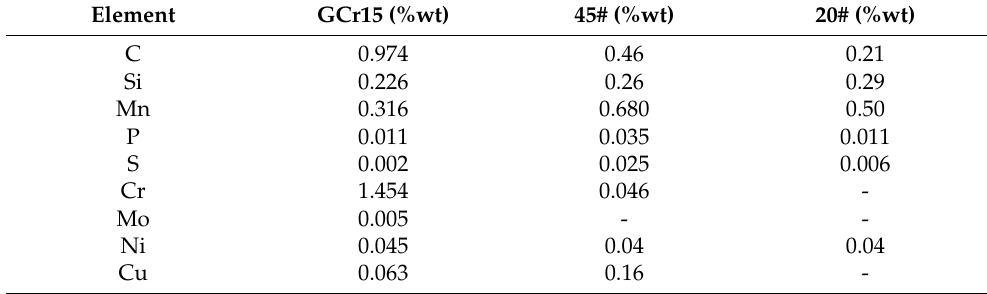
Table 2. Components of